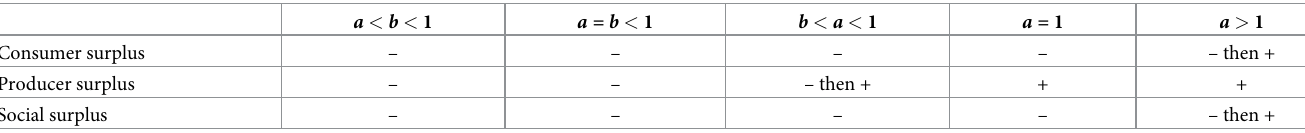
Table 5. The dynamics of producer and consumer welfares under climate